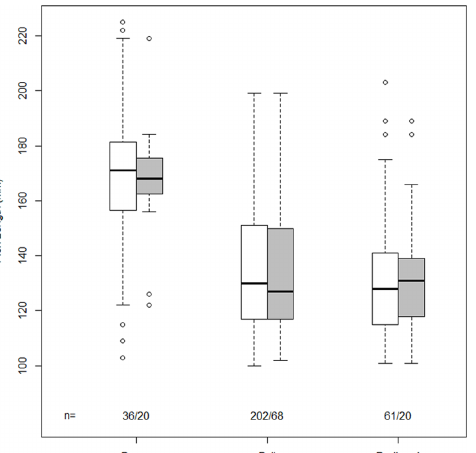
Fig 1. Box plots of fish length (mm) for all PIT-tagged brown trout, bull trout, and redband trout in Leonard Creek, Brownsworth Creek, and Boulder Creek (white box) and for those individuals that were redetected (gray box). The lower and upper boundaries of each box indicate the 25th and 75th percentiles, respectively, and the median value is shown as a line within the box. The lines (whiskers) below and above each box represent the 10th and 90th percentiles. All outliers are